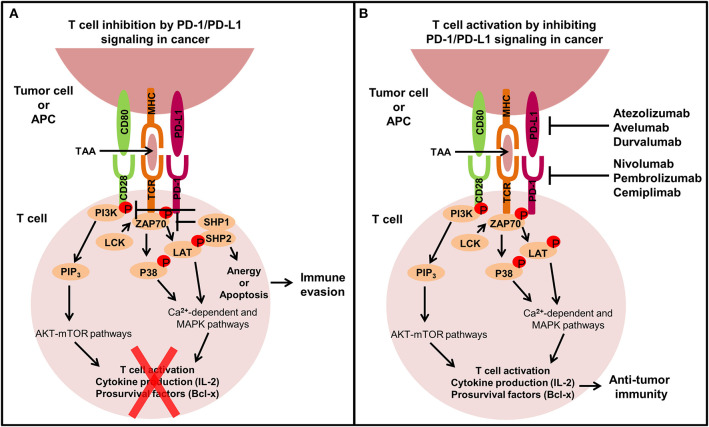
The extrinsic function of the PD-1/PD-L1 signaling axis in cancer. T cells play an important role in modulating immune responses against tumor cells, but tumors can exhibit immune inhibitory mechanisms like overexpressing PD-L1 to avoid T cell-mediated killing. (A) When PD-L1 binds to PD-1 expressed on the surface of T cells, T cells become inactivated through the recruitment of SHP1/2 which subsequently inhibits TCR and CD28 co-stimulatory signaling by preventing the phosphorylation of ZAP70 and PI3K, leading to T cell anergy or apoptosis and ultimately immune evasion. (B) Monoclonal antibodies targeting the PD-1/PD-L1 signaling axis have been developed to restore immune-mediated eradication of the tumor. PD-1/PD-L1 blockade allows co-stimulatory signal transduction from the TCR and CD28 on T cells upon interaction with APCs or tumor cells. TCR binding to the tumor-associated antigen (TAA) in the MHC complex leads to the phosphorylation of ZAP70, which then phosphorylates P38 and LAT resulting in activation of calcium-dependent and MAPK pathways. Simultaneously, CD80 binding to CD28 phosphorylates PI3K which activates PIP3 leading to AKT-mTOR pathway activation. These signaling pathways promote T cell activation, cytokine production and pro-survival factor expression stimulating anti-tumor immunity.